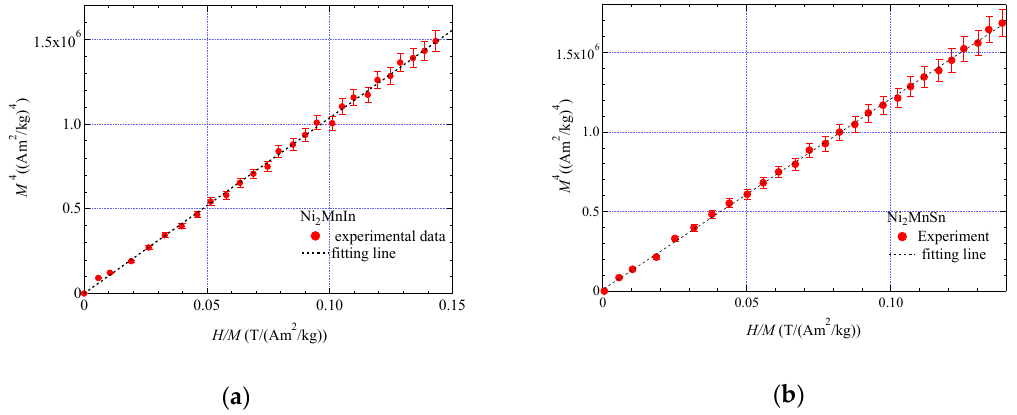
Figure 3. The magnetic field dependences of the magnetization, M 4 vs. H / M at T C : ( a ) Ni 2 MnIn; ( b ) Ni 2 MnSn. Dotted straight lines are linearly fitting lines.